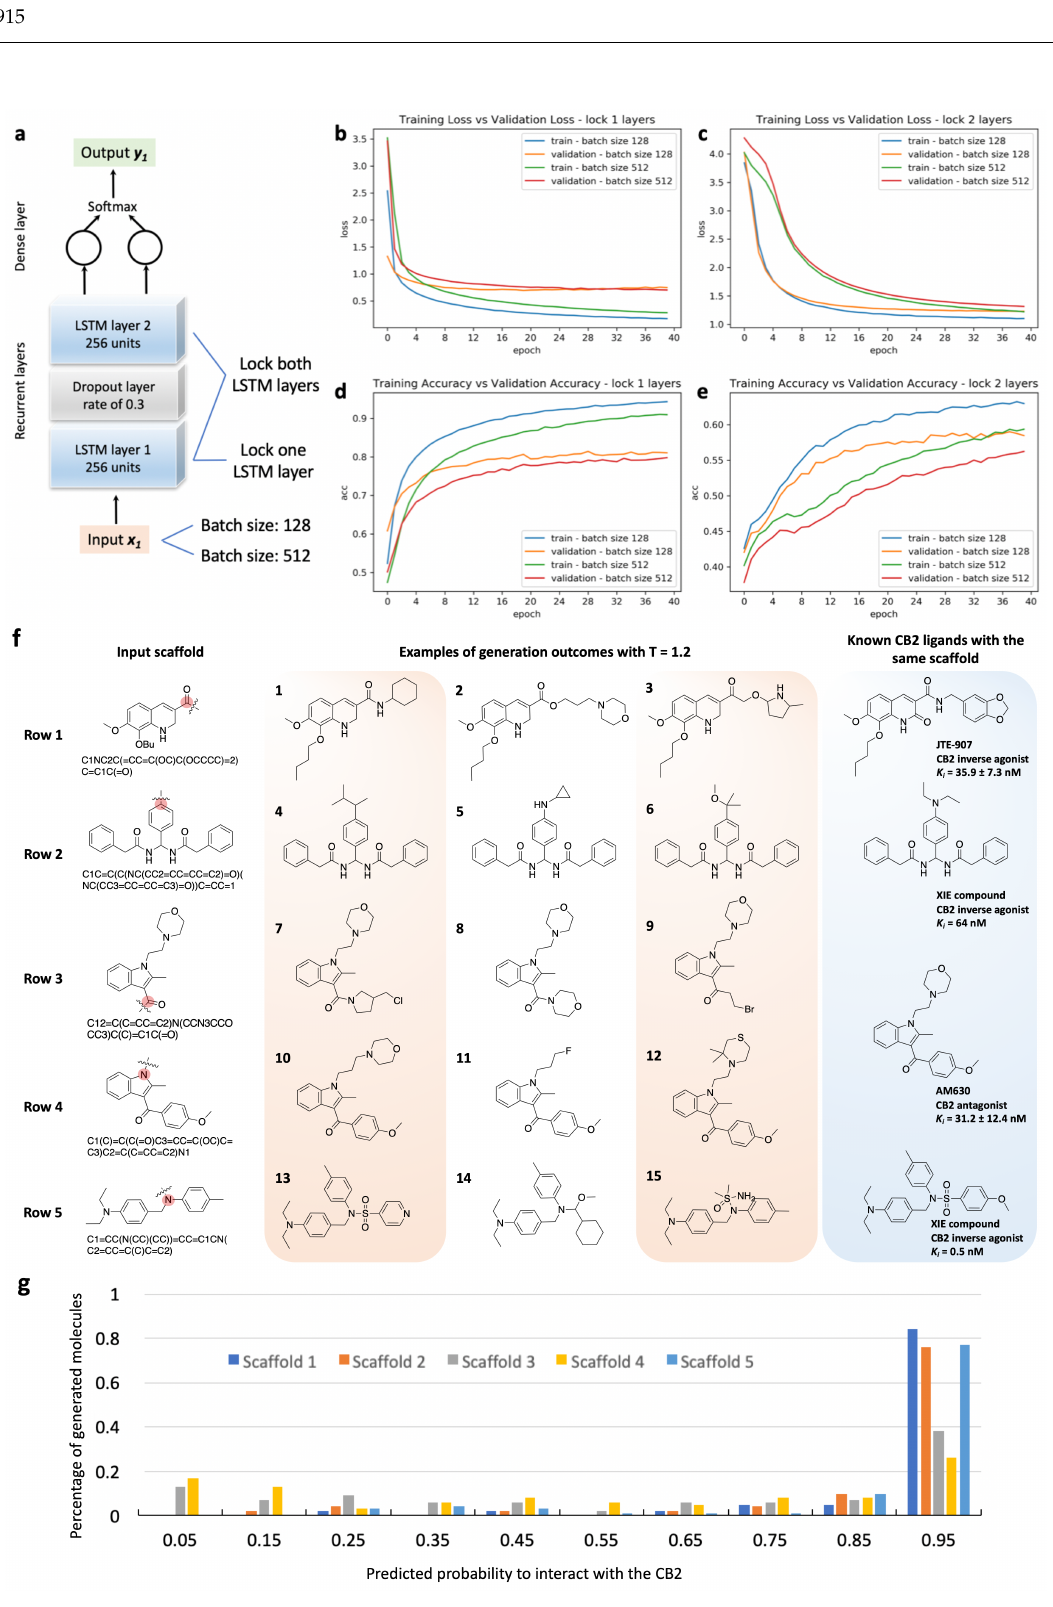
Figure 5. Developing t-DeepMGM to sample CB2 target-specific molecules after the transfer learn- ing. ( a ) Architecture of the t-DeepMGM in transfer learning. The transfer learning processes with either one LSTM layer locked ( b , d ) or both LSTM layers locked ( c , e ) are performed for comparison. The influence of using different sizes of mini-batches (128 and 512) was also evaluated. ( f ) Molecular sampling examples from the t-DeepMGM for four known CB2 scaffolds. ( g ) The distribution of the predicted likelihood of generated CB2 molecules by the MLP